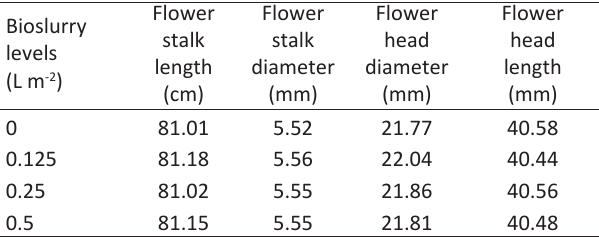
Table 1 - Residual effect of bioslurry on carnation flower quality Bioslurry